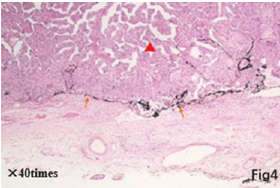
Figure 4: Red triangle for large carcinoma lesions; yellow arrow for tracer dye black lymphatic